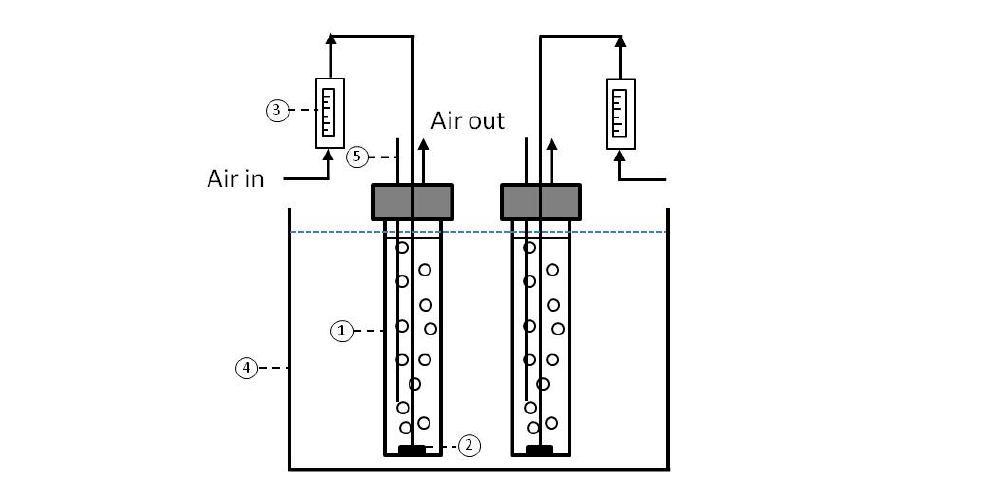
Figure 3. Flow sheet of the bioreactor system used in biodesulfurization of biphasic media by resting cells of R. erythropolis IGTS8: (1) glass cylinder; (2) sparger; (3) gas flow meter; (4) water bath; (5) sampling port.